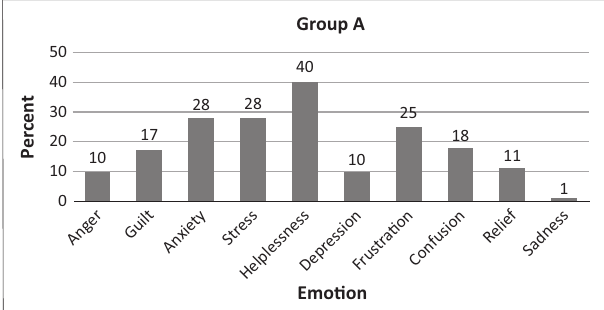
FIGURE 1: Emotions of parents in Group A when their child was diagnosed with dyslexia.